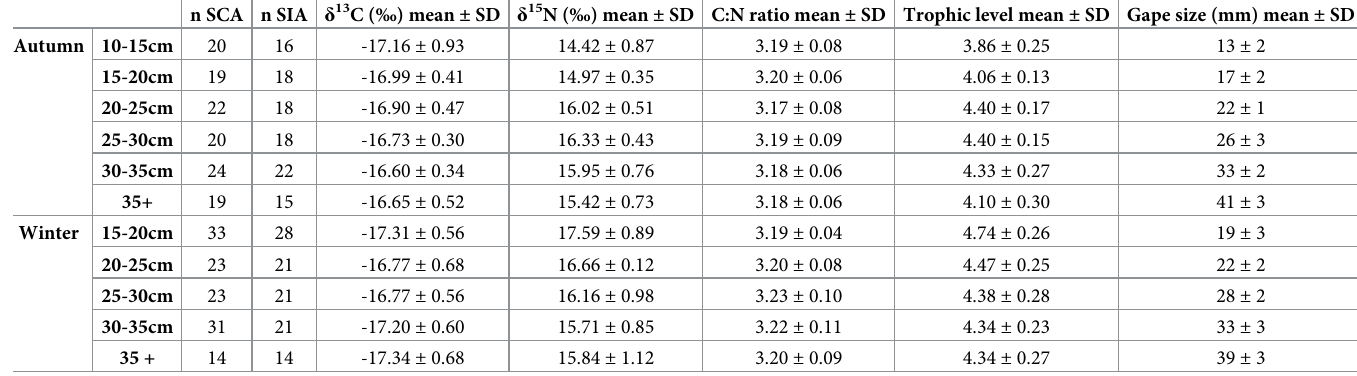
Table 1. Number of stomach content (n SCA) and stable isotopes (n SIA) analyzed by size classes, mean and range in stable isotopes ratios (mean δ 15 N ± SD, mean δ 13 C ± SD) observed and gape size for both seasons (autumn and